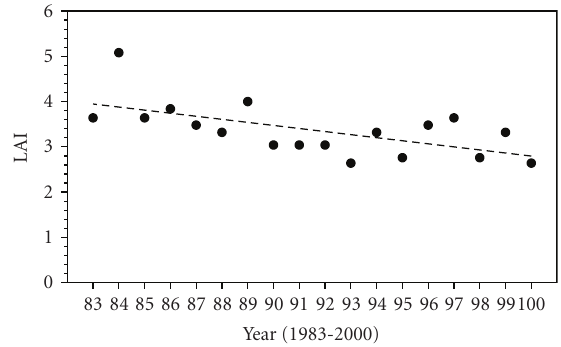
Figure 2: The trend of the annual maximum LAI at the Xinghai station for the period of 1983–2000. The dashed line represents the trend. The black dot is the maximum LAI for each